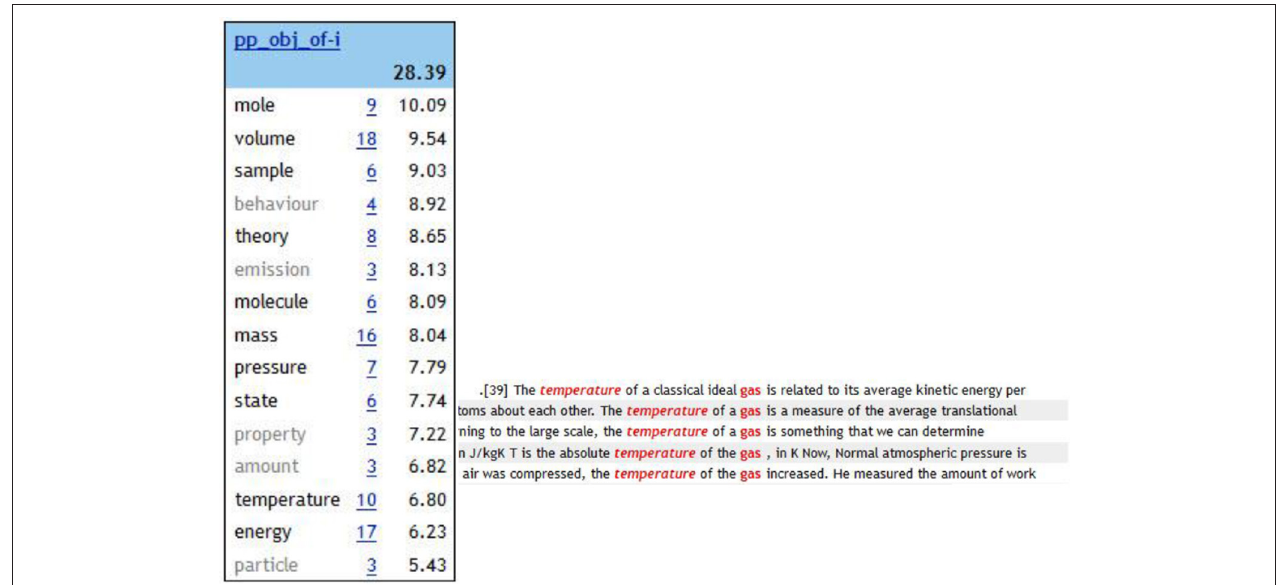
FIGURE 6 | Word sketch gas .